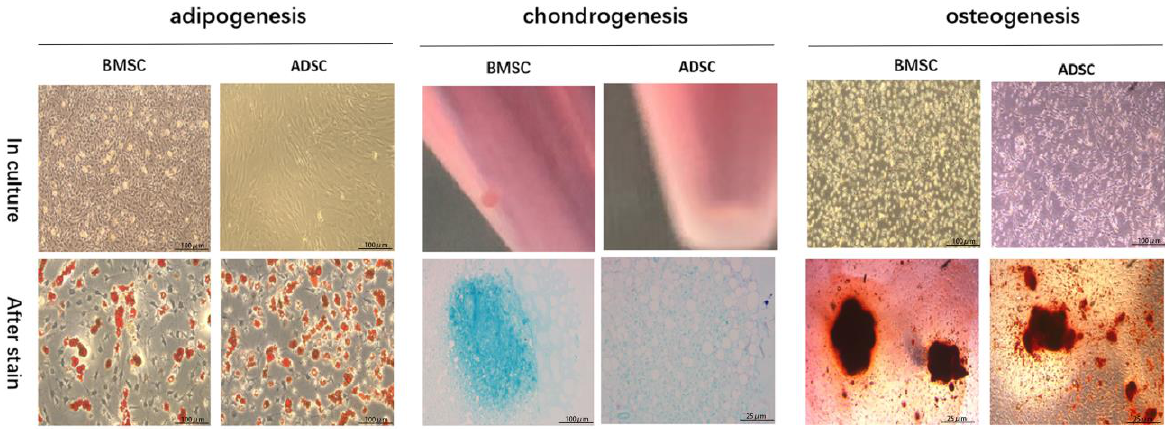
Figure 1. Differentiation of BMSC and ADSC into adipocytes, chondrocytes and osteoblasts. Repre- sentative images showed the cell morphology in culture after induction (top row) and the staining results of oil red stain for adipogenesis, alcian blue stain for chondrogenesis, and alizarin red stain for osteogenesis.